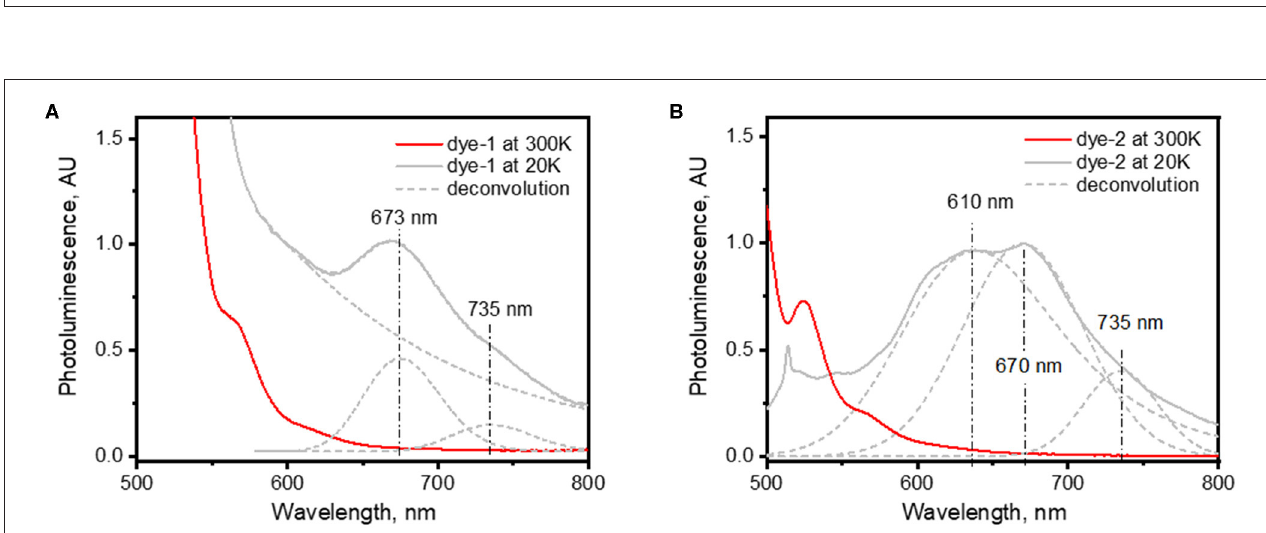
FIGURE 3 | Photoluminescence of (A) dye-1 and (B) dye-2 at temperature of 300 and 20K. Dashed lines represent results of deconvolution of low-temperature photoluminescence using Gaussian peaks centered at 673 and 735nm for dye 1 and 610, 670, and 735nm for dye 2 .